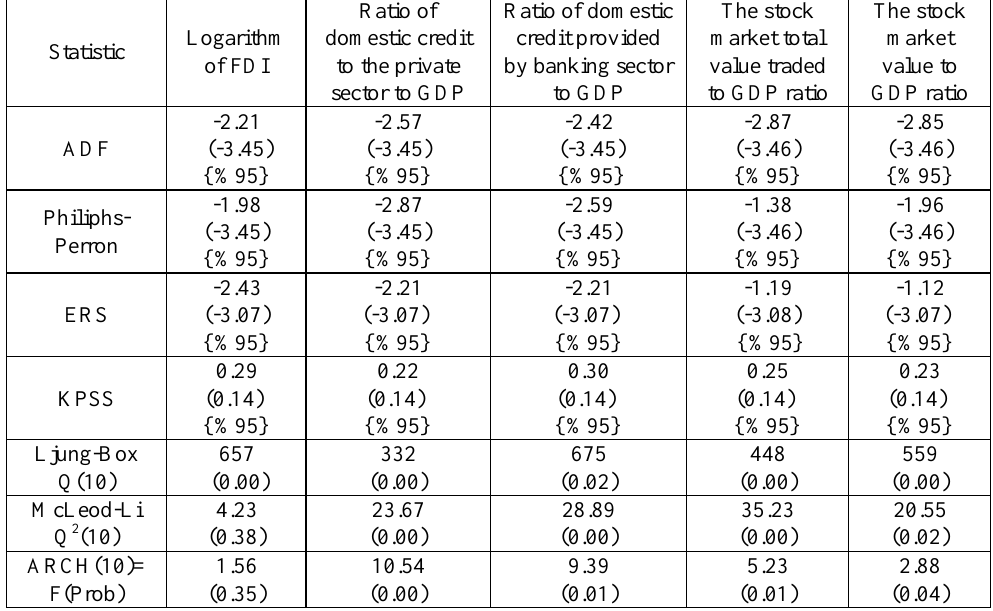
Table 2. Results of unit root, auto-correlation and heteroskedasticity